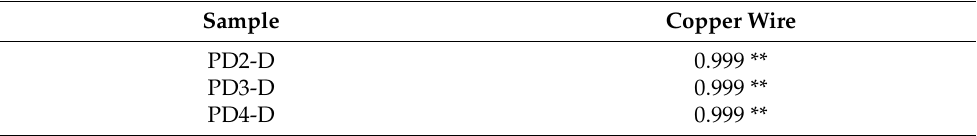
Table 6. Pearson’s correlation coefficient between output signals of the sample and copper wire.